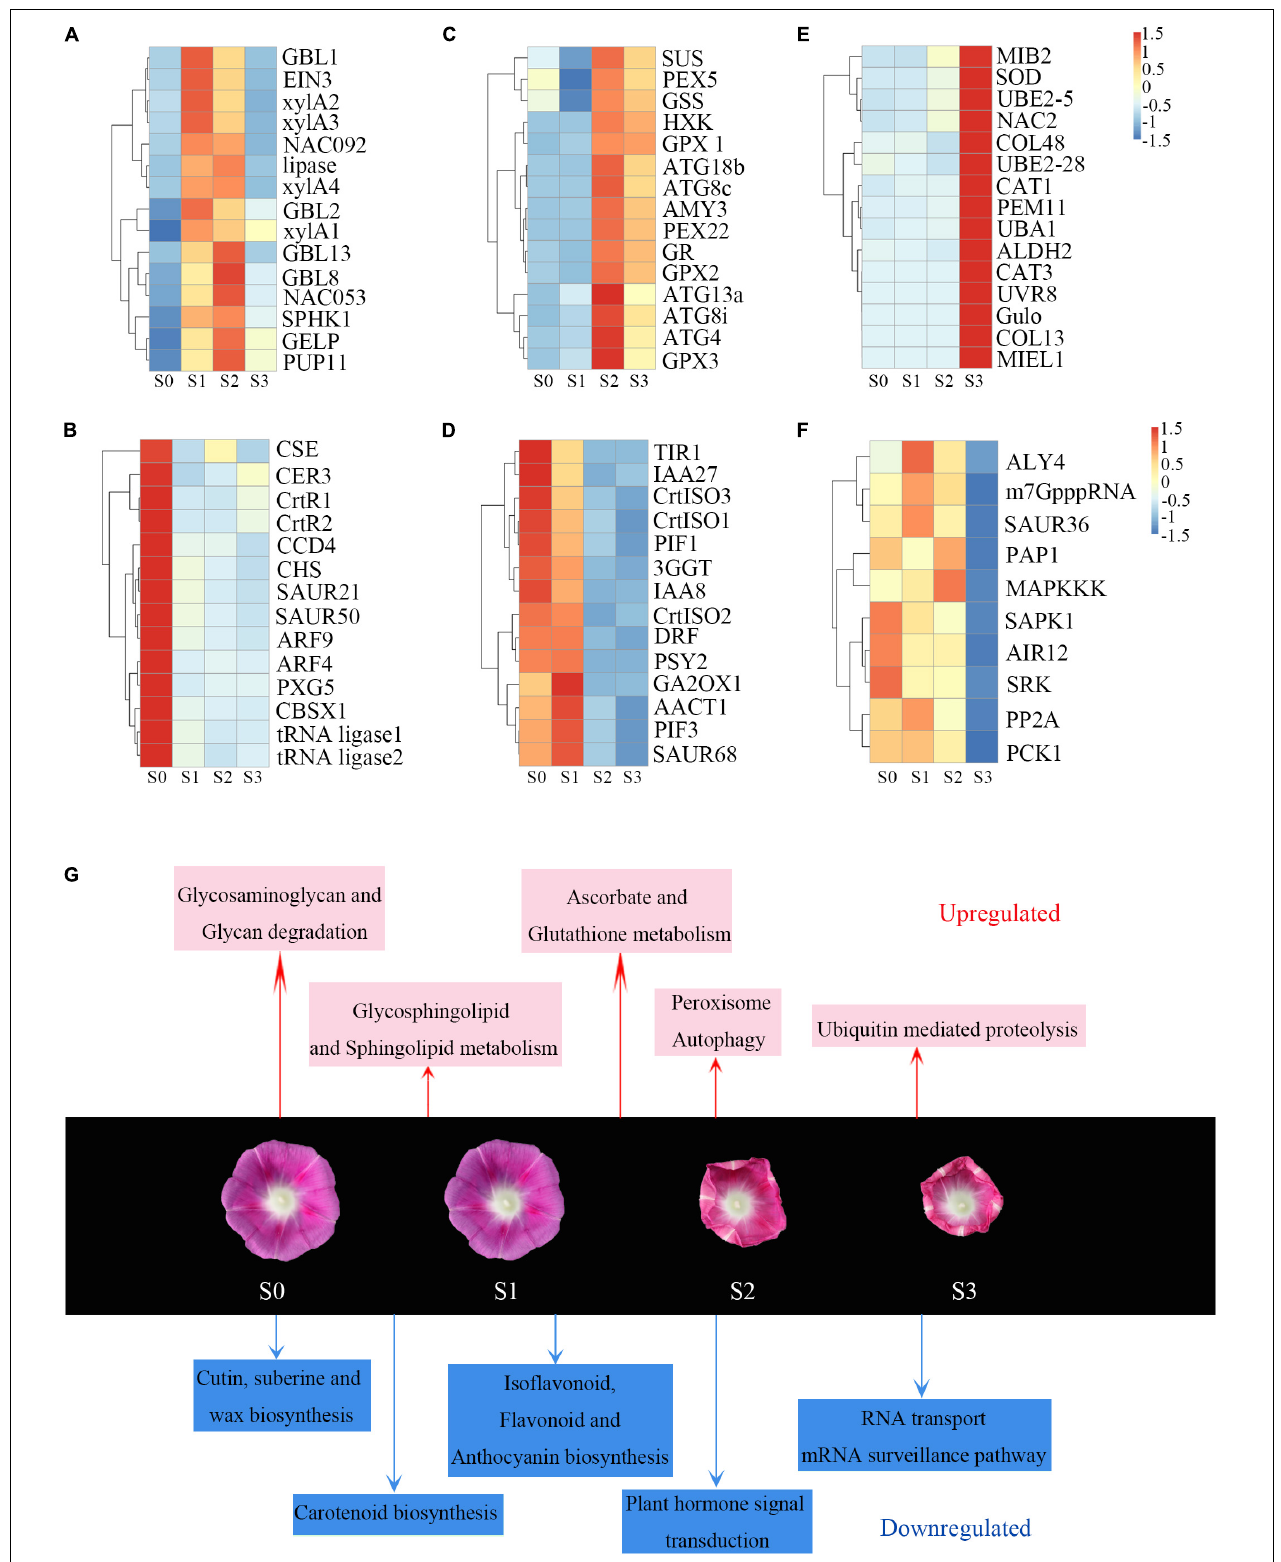
FIGURE 5 | Heat maps of induced and repressed genes and metabolic processes during corolla closure. (A–F) Heat maps of upregulated and downregulated genes in different clusters. Abbreviations are described in Supplementary Table 3 . (G) Metabolic processes induced and repressed at different time points during corolla closure. Red and blue indicate the induced and repressed processes,